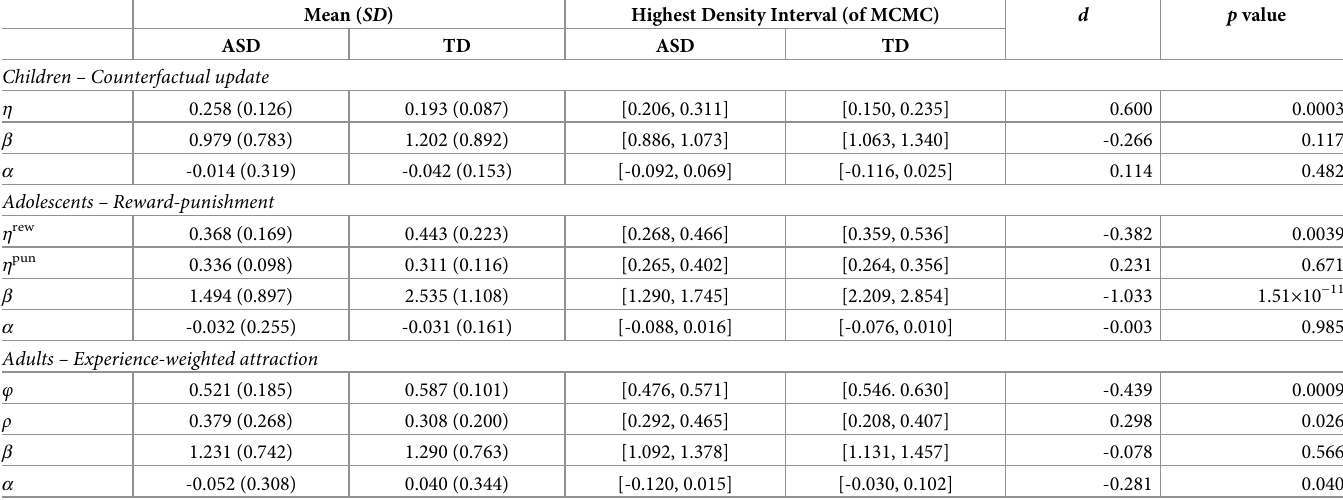
Table 2. Model parameters for each age and diagnosis group’s winning model and within age-group